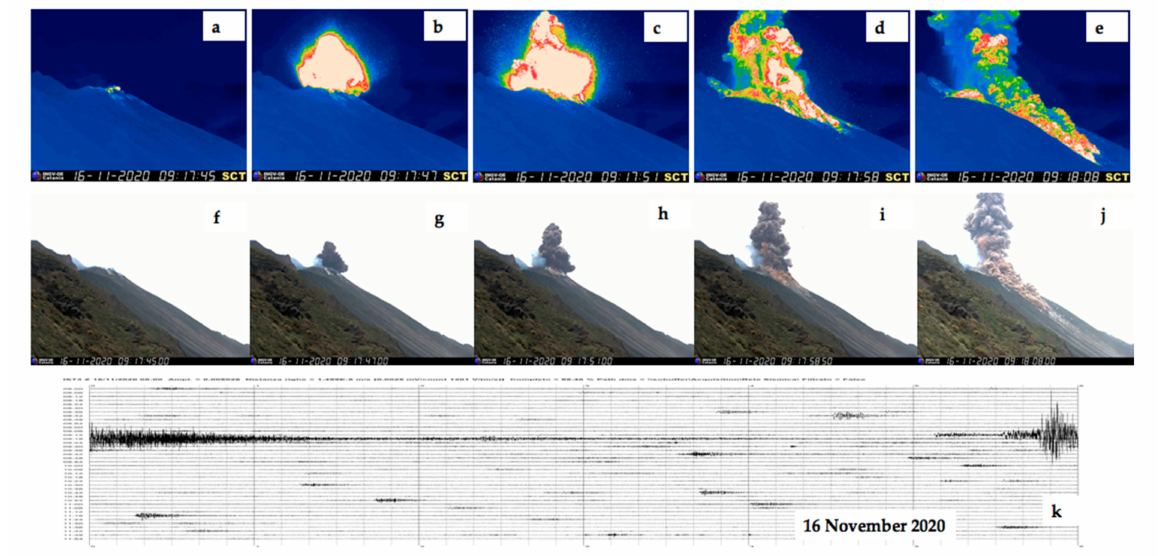
Figure 12. ( a – e ) Thermal images of the SCT camera recorded at 09:17:45 ( a ), 09:17:47 ( b ), 0917:51 ( c ), 09:17:58 ( d ), and 09:18:08 ( e ), and ( f – j ) corresponding visual images from the SQV camera of the 16 November 2020 event, view from NE. Blue is cold, white is hot. ( k ) Seismic trace of the event recorded by the IST3 station. See Figure 1 for station locations.